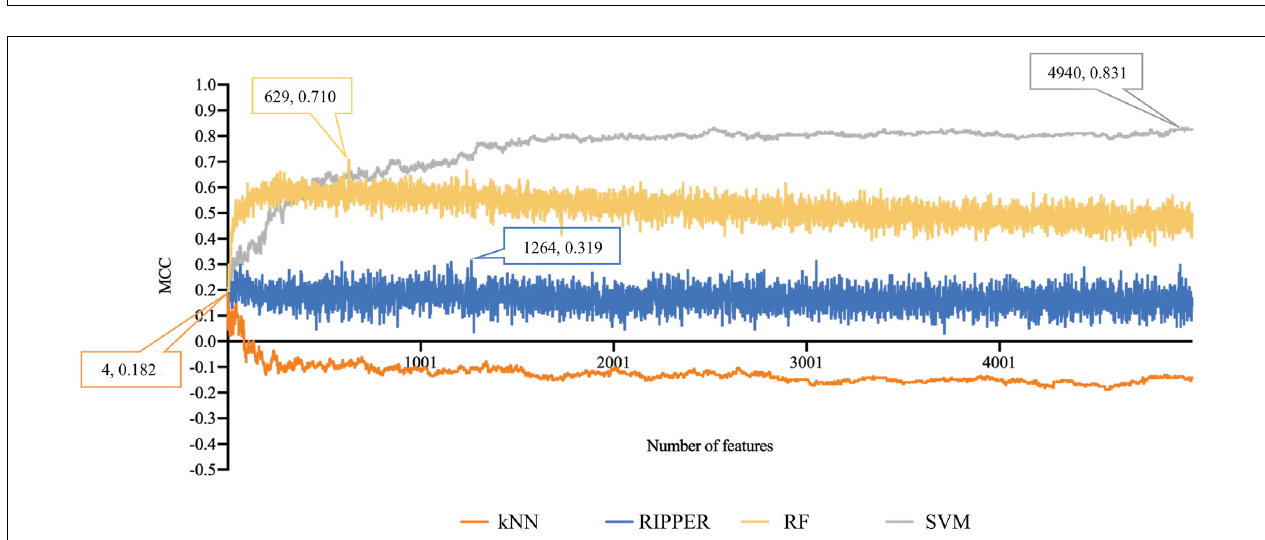
FIGURE 2 | Performance curves of IFS with RF, SVM, kNN, and RIPPER under different numbers of features for methylation data. SVM yields the highest MCC of 0.831.